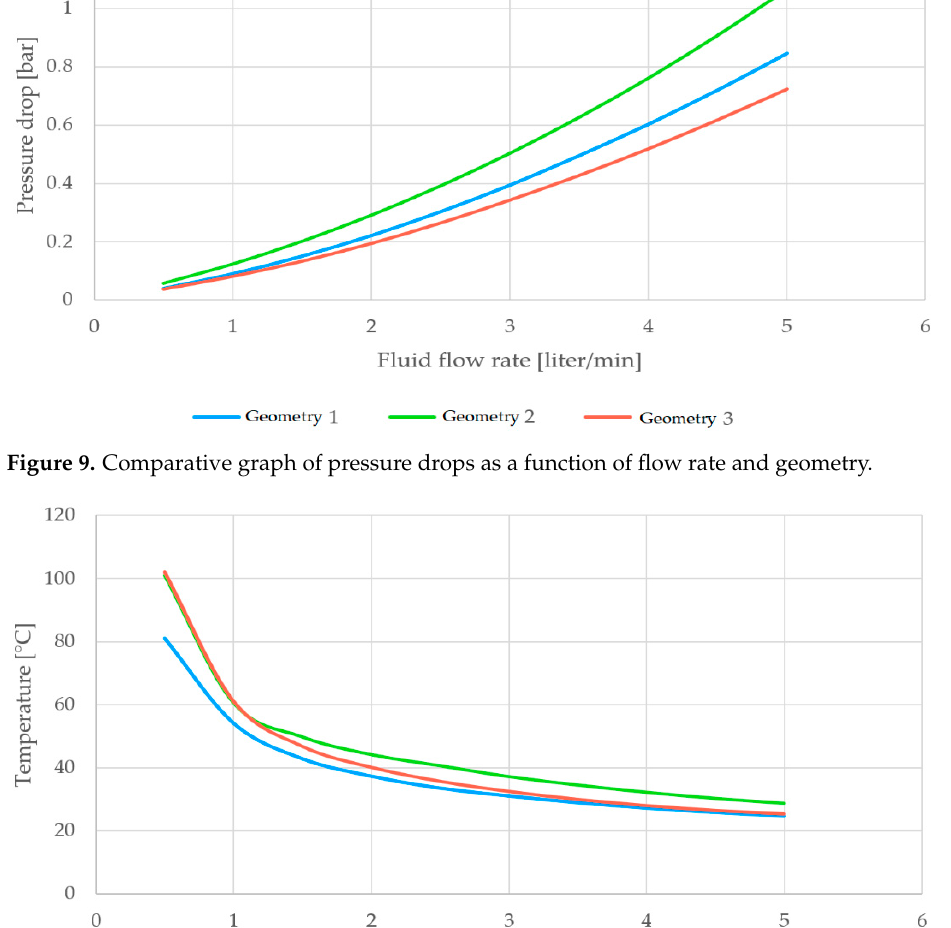
Figure 10. Comparative graph of the maximum busbar temperature as a function of flow rate and geometry for C-rate = 4.